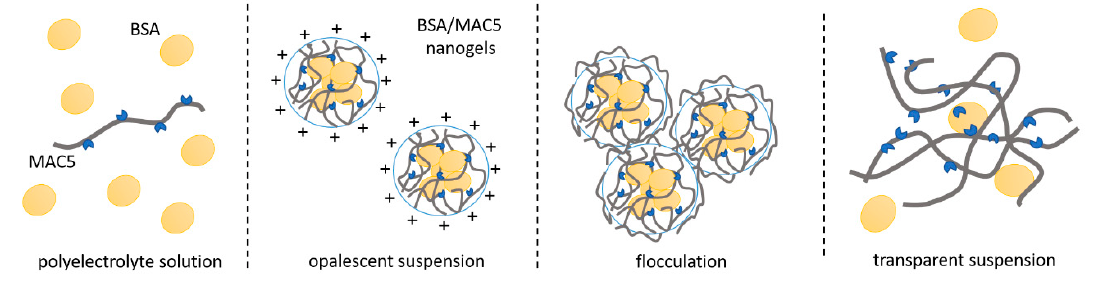
Figure 1. Types of phenomena that appear during BSA/MAC complexation.